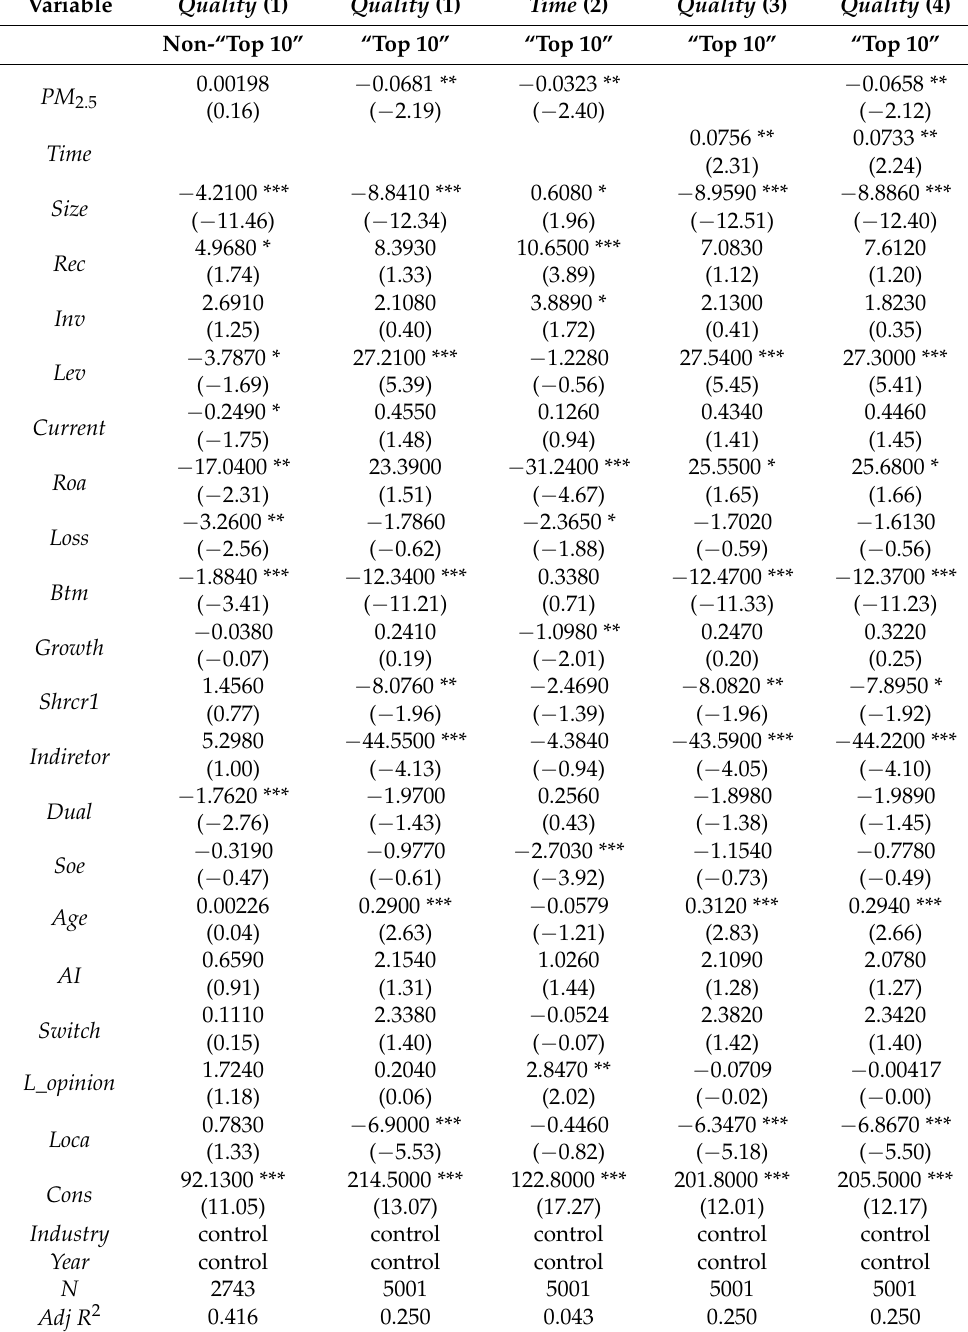
Table 4. Group test regression